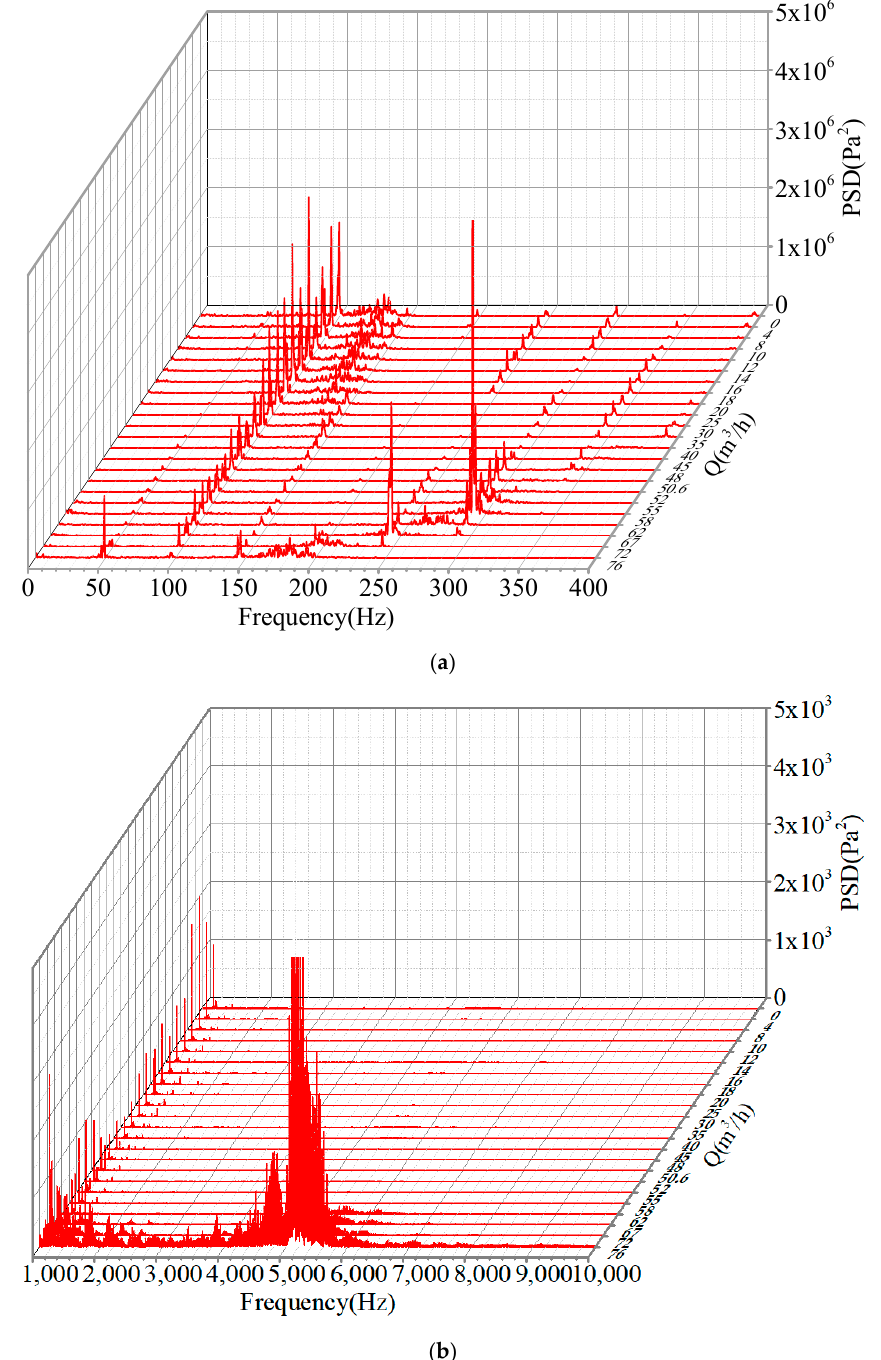
Figure 18. PSD of the acoustic pressure measured by pump outlet hydrophone 2 at different flow rates. ( a ) 0–400 Hz; ( b ) 1–10 kHz.